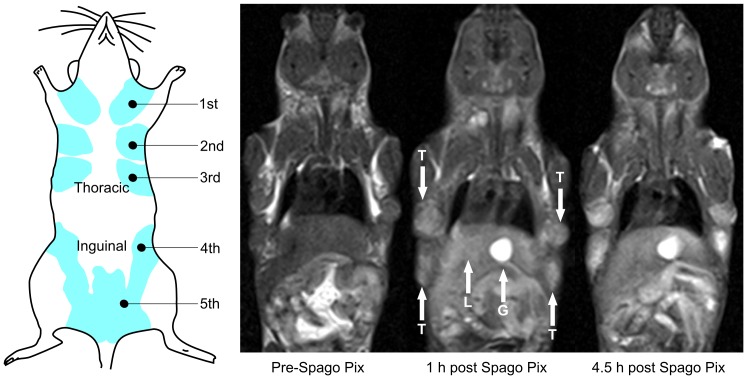
Illustration of mammary gland localization in the mouse and T
1-weighted MR images of pre-injection and 1 h and 4.5 h post injection, respectively, of Spago Pix.The 1 h image has tumors (T), liver (L) and gall bladder (G) indicated with white arrows. Note that the pre-injection image is without applied fat saturation.